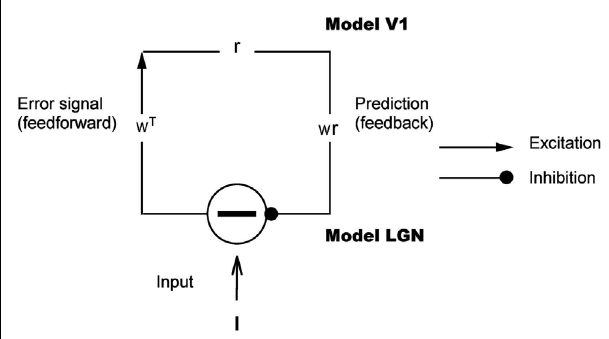
FIGURE 1 | Hierarchical model for predictive coding. Higher-level units attempt to predict the responses of units in the next lower level via feedback connections, while lower-levels signal the difference between the prediction and the actual input. Feedforward connections encode the synaptic weights represented by a matrix W T . Higher-level units maintain the current estimate of the input signal r and convey the top-down prediction W r to the lower level via feedback connections. Difference detectors compute the difference I − W r between current activity I and the top-down prediction W r